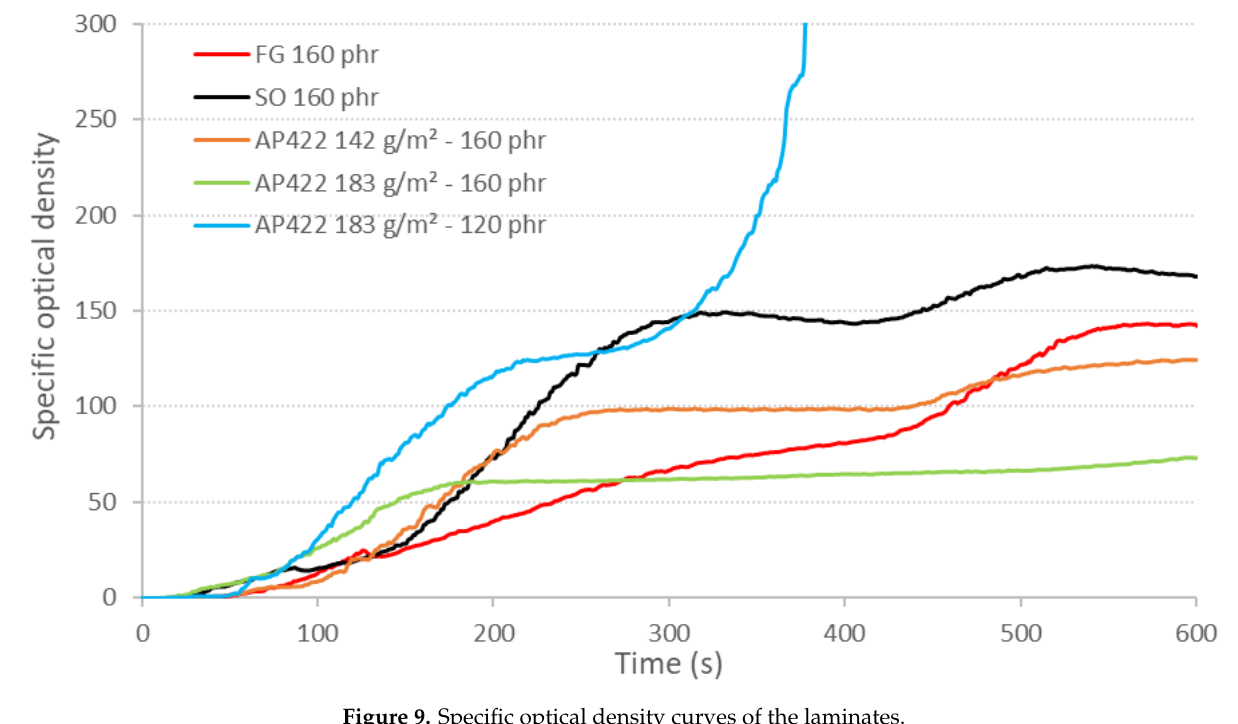
Figure 9. Specific optical density curves of the laminates.